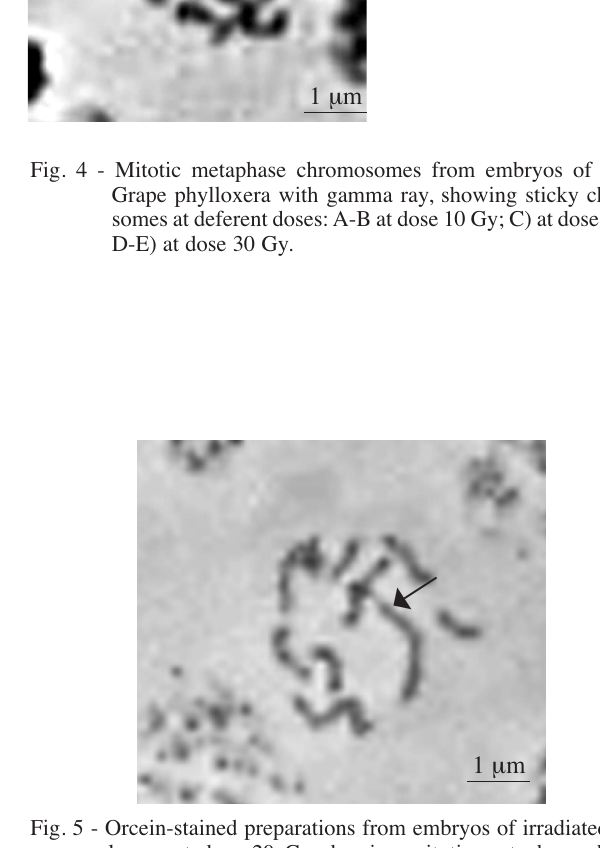
Fig. 5 - Orcein-stained preparations from embryos of irradiated phyl- loxera at dose 20 Gy showing mitotic metaphase chromo- somes with a translocation on the large chromosome (the arrow).